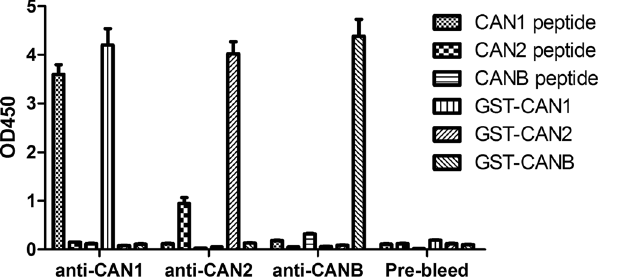
Figure 1. Binding of mono-specific antibodies to the peptides and fusion proteins. Peptides or GST-fusion proteins were coated onto 96-well plates, followed by incubation with the antibodies and subsequently detection with HRP-conjugated secondary antibodies.